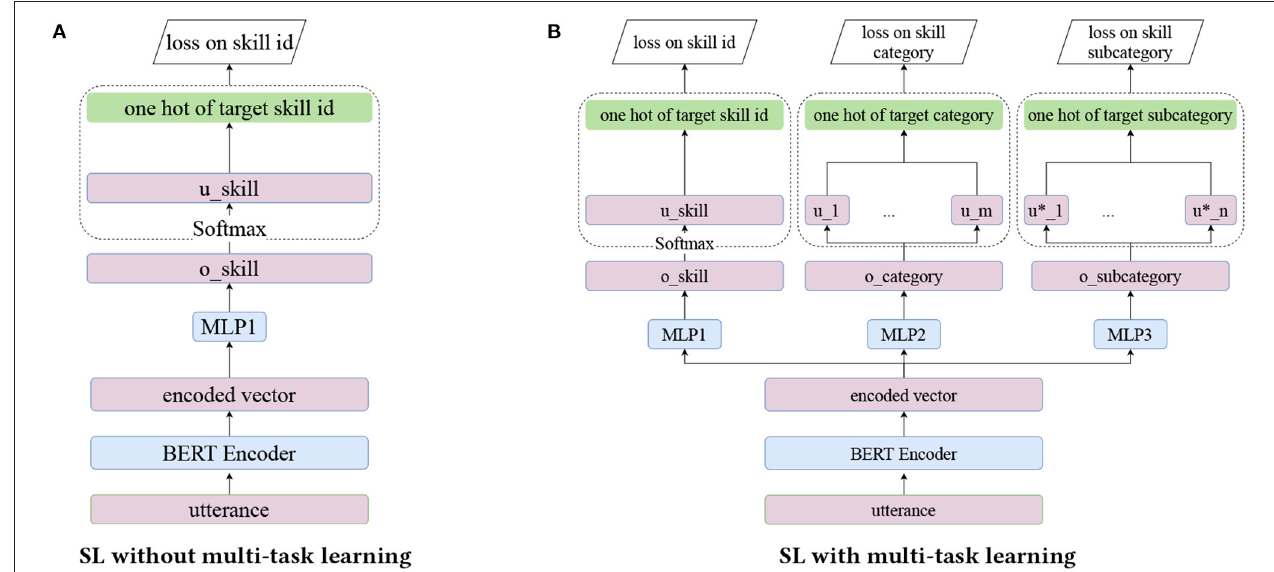
FIGURE 2 | Model architecture of shortlister model. (A) SL without multi-task learning. (B) SL with multi-task learning.